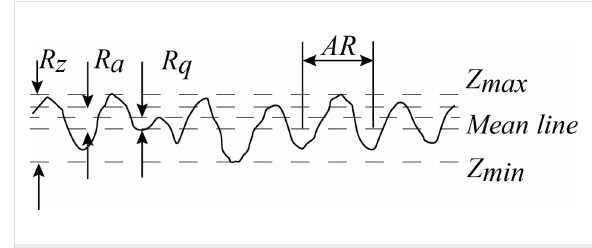
Figure 2: Schematic illustration of a rough surface. The parameters of the profile defined here are the mean line, the average width of the roughness pitch ( AR ), the peak to valley roughness ( R z ), the average roughness ( R a ), the root mean squared roughness ( R q ), the height of peaks ( Z max ) and height of valleys ( Z min